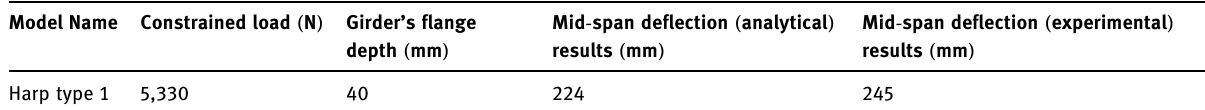
Table 1: De fl ection results for FE models